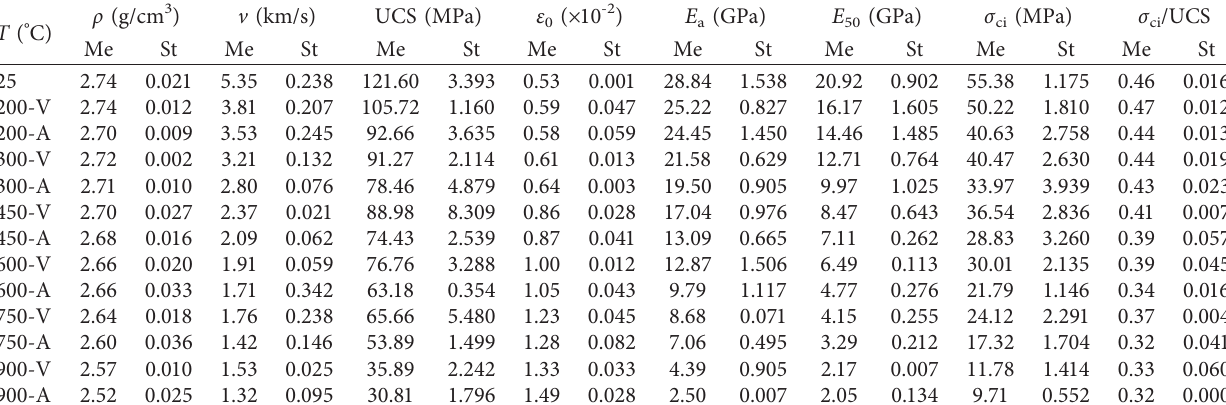
Figure 4: Variations in (a) density and (b) ultrasonic velocity of limestone with different temperatures under different heating conditions (error bar indicates one standard deviation). Table 1: Physical and mechanical parameters of limestone after heat treatment under different heating